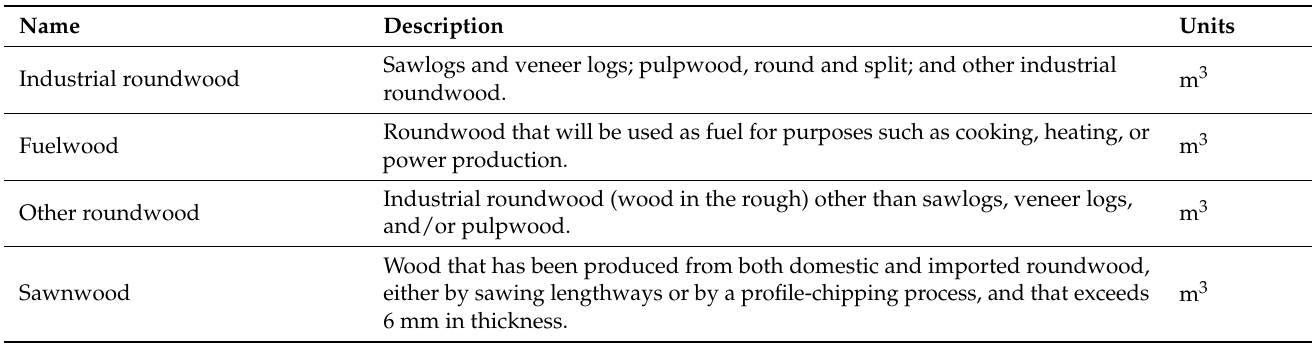
Table A1. Wood product categories represented in